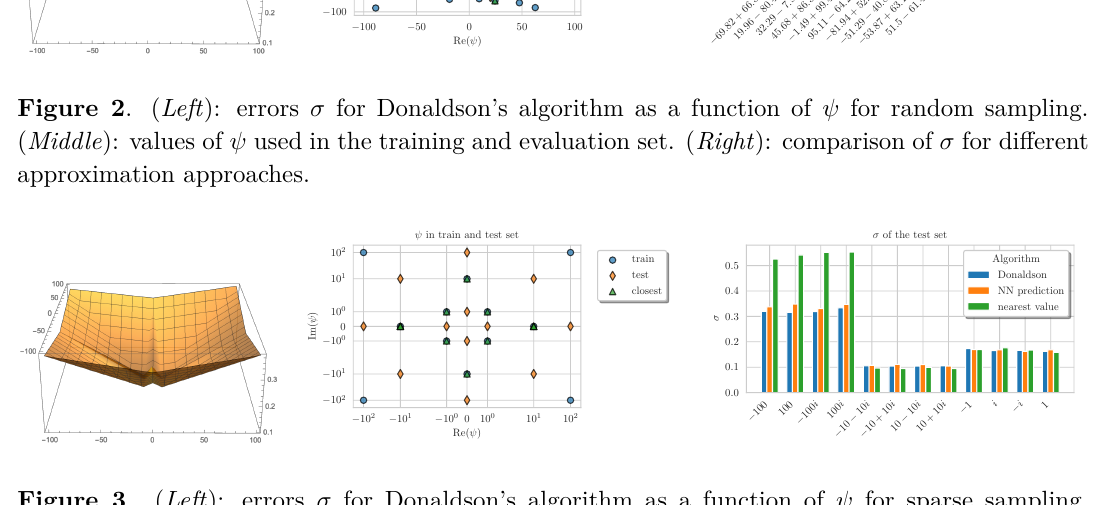
Figure 3 . ( Left ): errors σ for Donaldson’s algorithm as a function of ψ for sparse sampling. ( Middle ): values of ψ used in the training and evaluation set. ( Right ): comparison of σ for different approximation